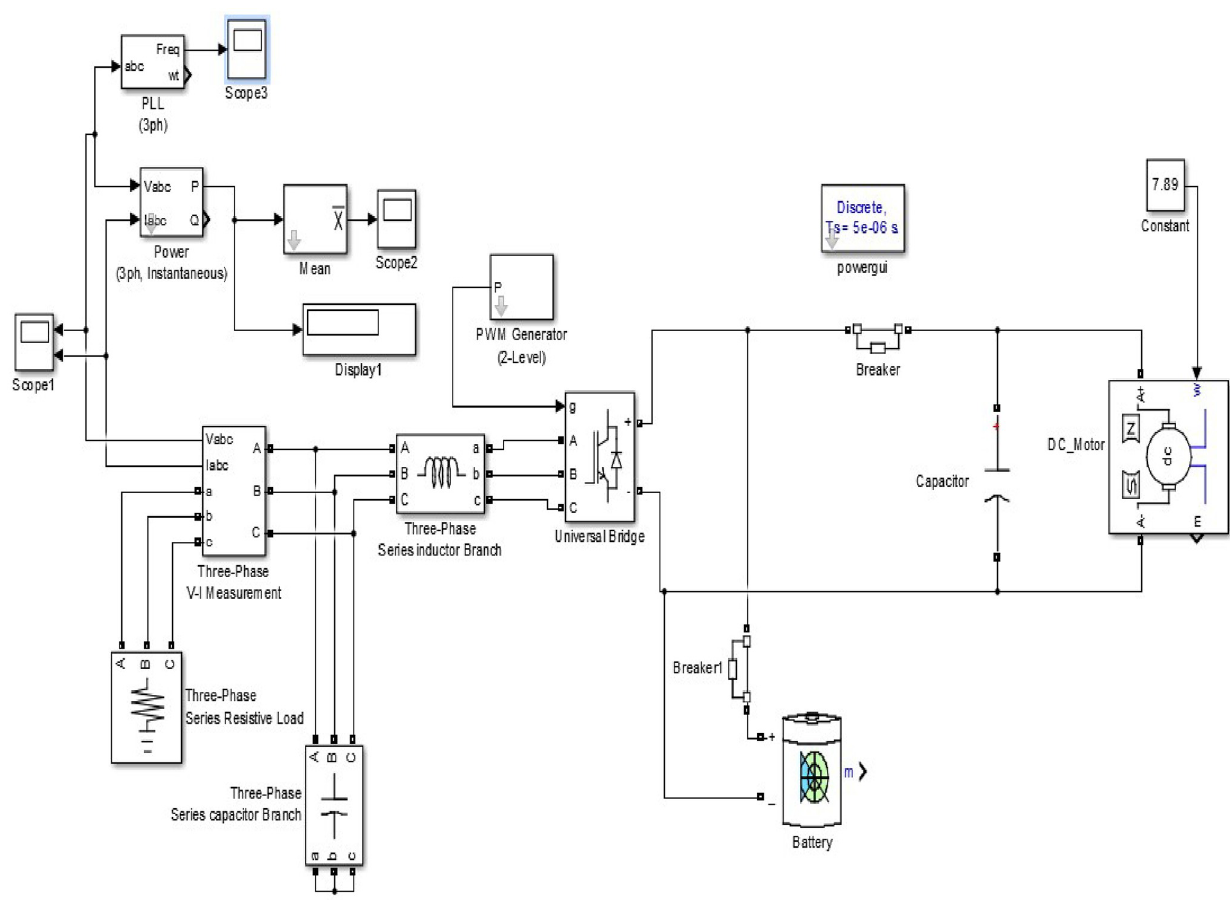
Fig 9. Simulation based model to verify the design